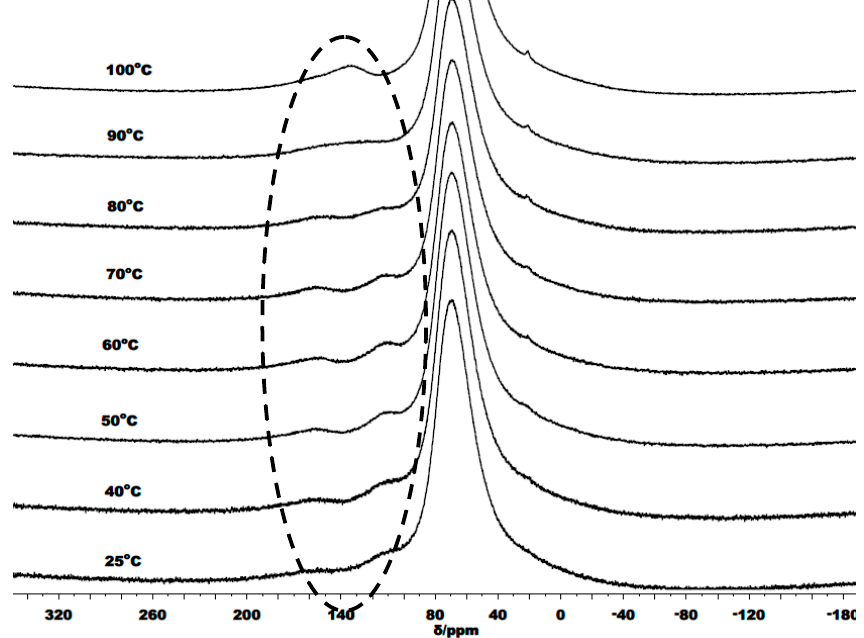
Figure 10. VT- 27 Al NMR spectra of C1 /BnOH recorded between 25 and 100 °C (in toluene- d 8 ); the broad signal at δ 68.0 derives from the aluminum alloy present in the NMR probe.